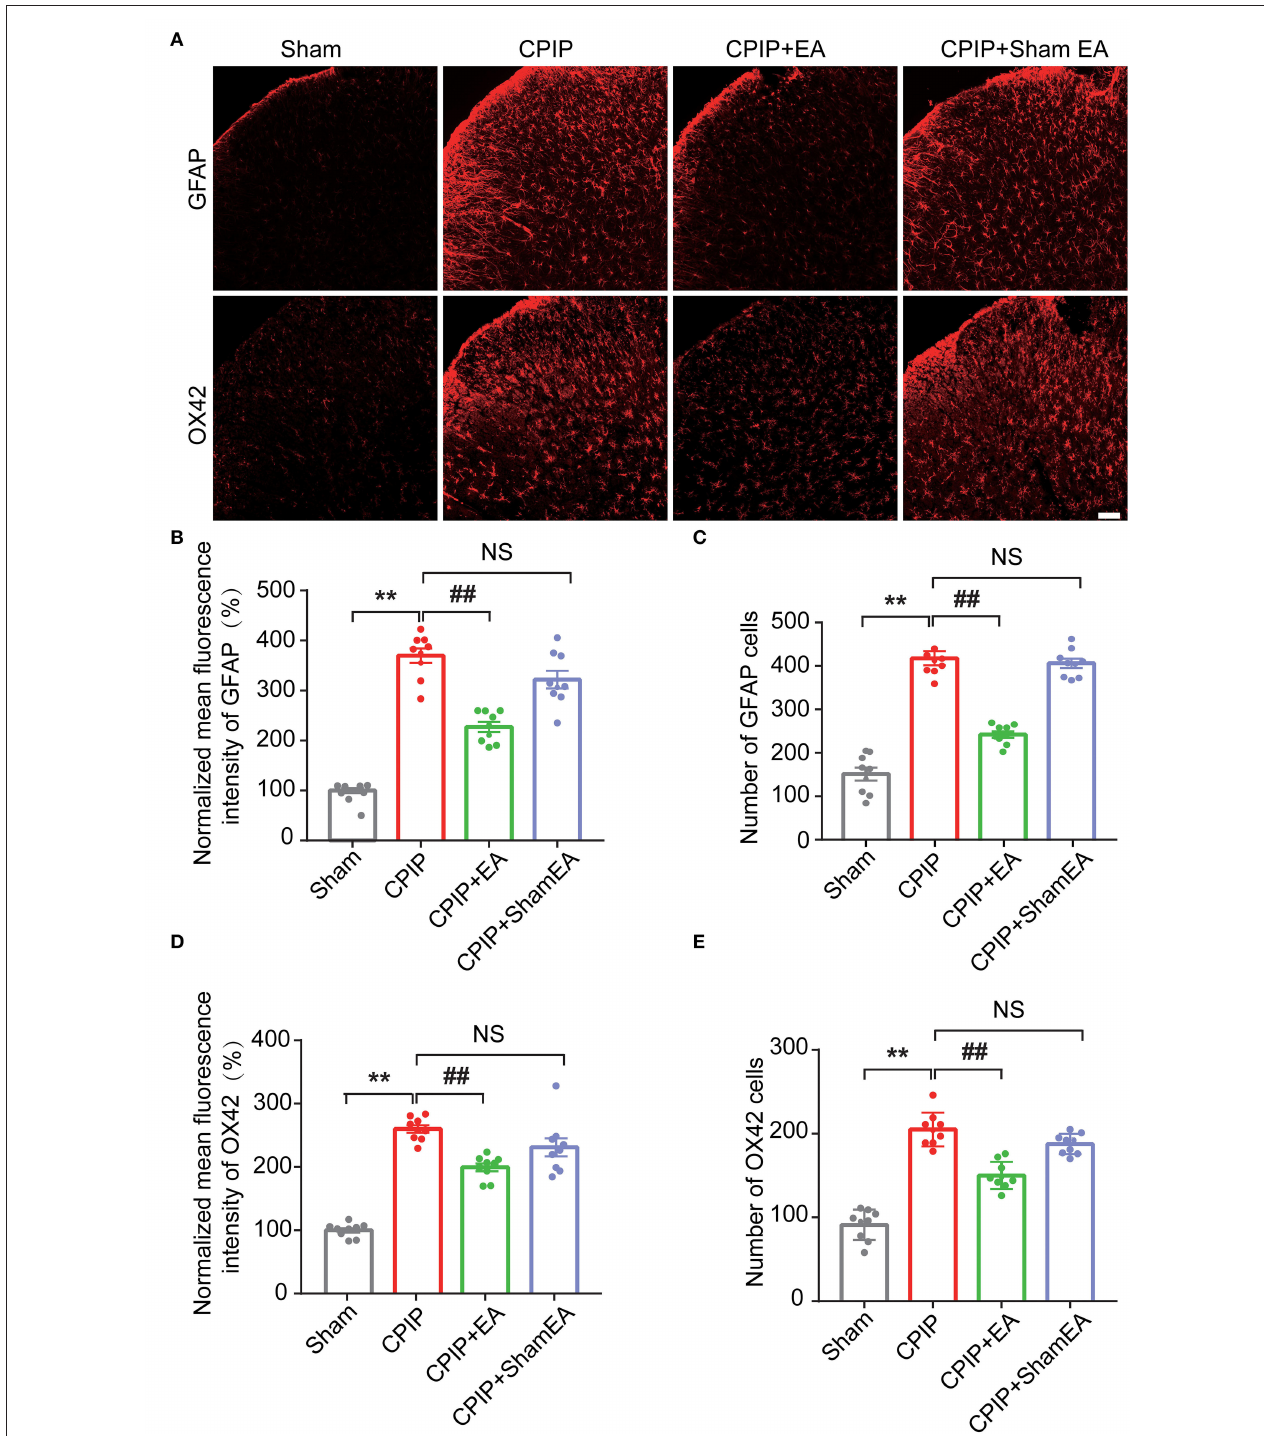
FIGURE 5 | EA intervention reduces glial cell overactivation in spinal cord dorsal horn of CPIP rats. (A) Immunostaining pictures showing the effect of EA/sham EA intervention on astrocyte (Upper panels, marked with GFAP) and microglia (lower panels, marked with OX42) overactivation in SCDH. (B) Summary of the mean fluorescence intensity of GFAP, which were normalized with the value of sham group. (C) Summary of the total number of GFAP + cells/observation field. (D) Summary of the normalized mean fluorescence intensity of OX42, which were normalized with the value of sham group. (E) Summary of the total number of OX42 + cells/observation field. Scale bar indicates 100 µ m. Data were obtained from 9 rats/group. ** p < 0.01 vs. Sham group. ## p < 0.01 vs. CPIP group. NS, no significance vs. CPIP group. One-way ANOVA with Tukey’s post-hoc test was applied in (B–E) .